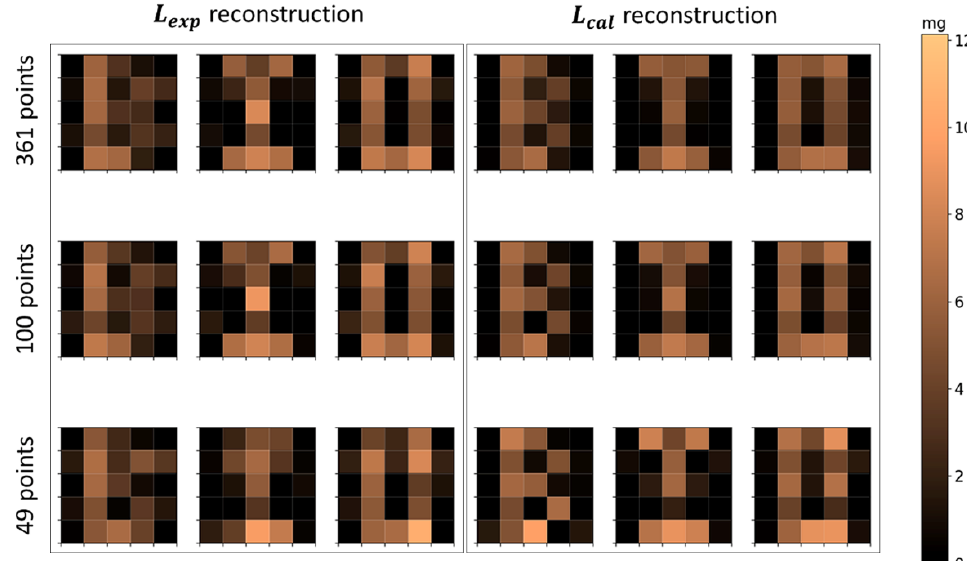
Figure 9. Reconstructed images of MNPs ’ distribution in the geometry of letters B , I , and O . The first row shows the reconstructions with 361 scanning points; the second row shows the reconstructions with 100 scanning points; and the third row shows the reconstructions with 49 points. The first three columns use 𝑳 𝒆𝒙𝒑 and the last three columns use 𝑳 𝒄𝒂𝒍 . Table 4. CC and 𝑋 𝑑𝑖𝑓𝑓 values for the ACB reconstructions of calculated signals of bars ’ geometries.